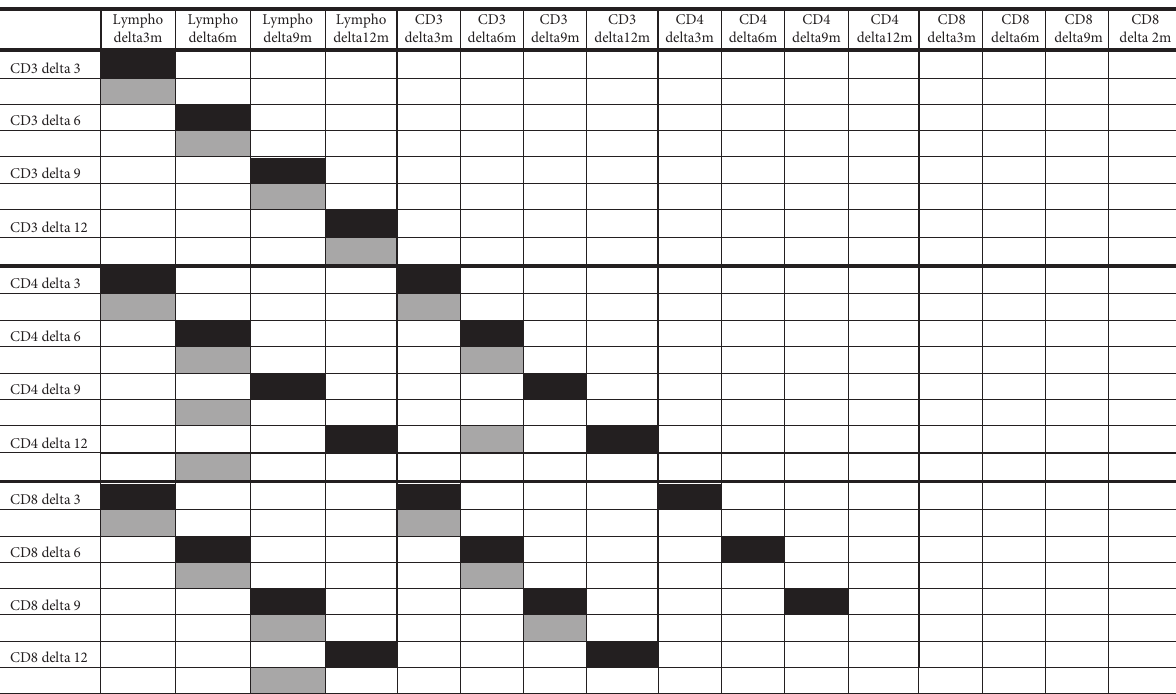
Table 2: Correlation between variations of cell population at different time